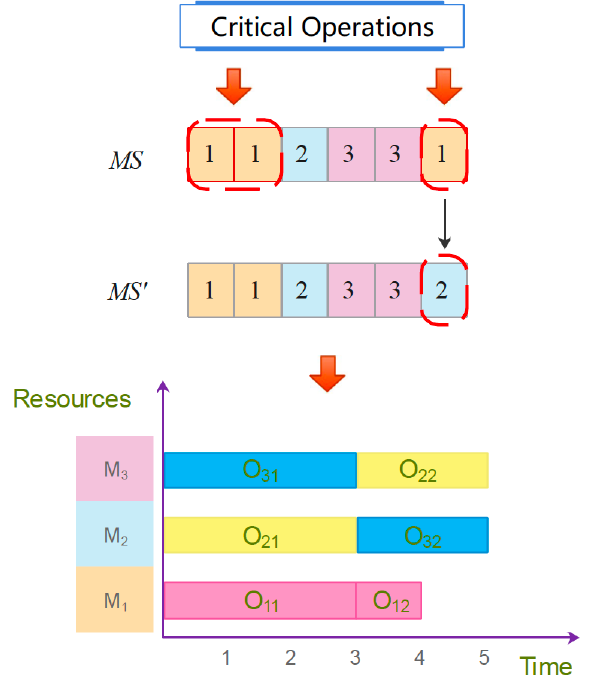
Figure 11. New solution obtained by selecting another random machine of a critical operation.